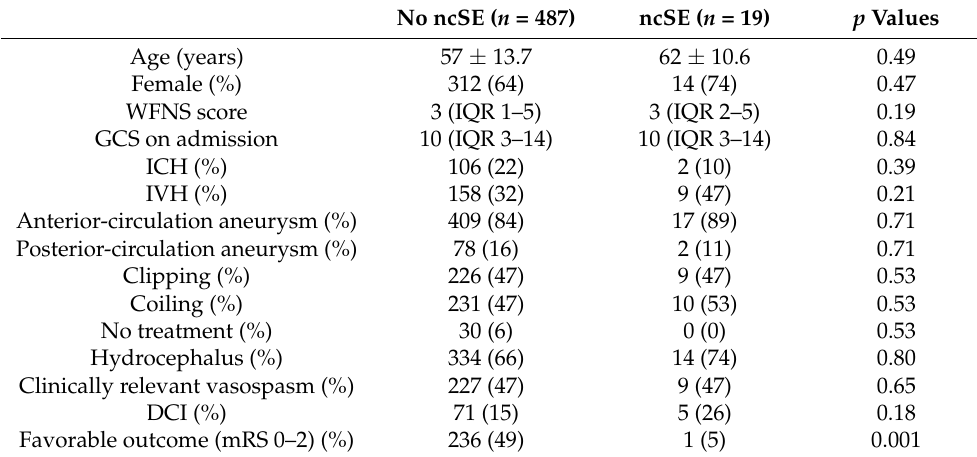
Table 1. Patient characteristics.